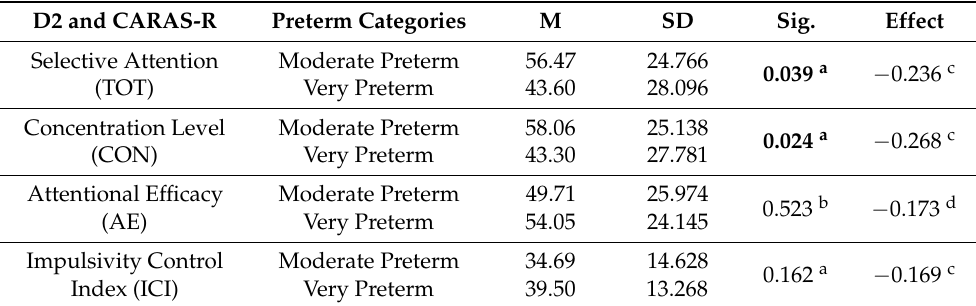
Table 5. Comparison of the average percentiles index of attentional skills in adolescents born moderate and very premature and the average percentiles of D2 and CARAS-R tests. Binomial Test: Mean of the Normative Group Moderate Premature Very Premature Attention Skills g.1.% p Effect g.1.% p Effect Selective Attention (TOT)